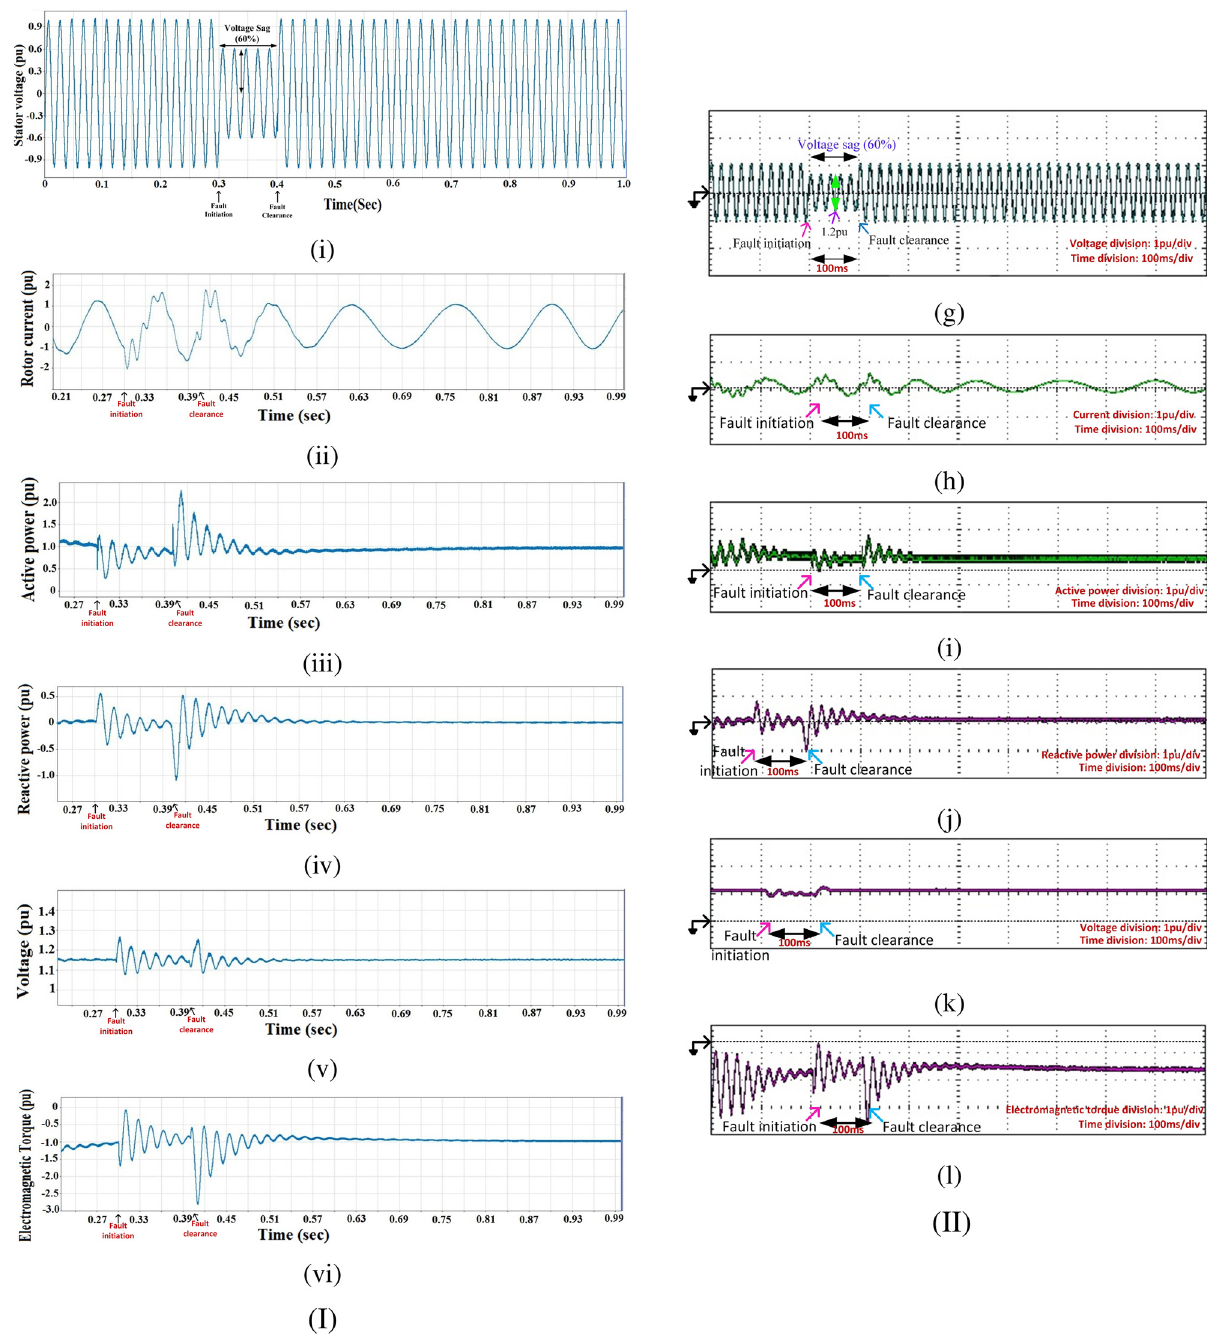
Figure 11: LVRT capability of DFIG with the proposed controller under 60% voltage sag ( i ) and ( g ) stator voltage ( ii ) and ( h ) rotor current ( iii ) and ( i ) active power ( iv ) and ( j ) reactive power ( v ) and ( k ) DC - link voltage ( vi ) and ( l ) electromagnetic torque. ( I ) Simulation results. ( II ) HIL